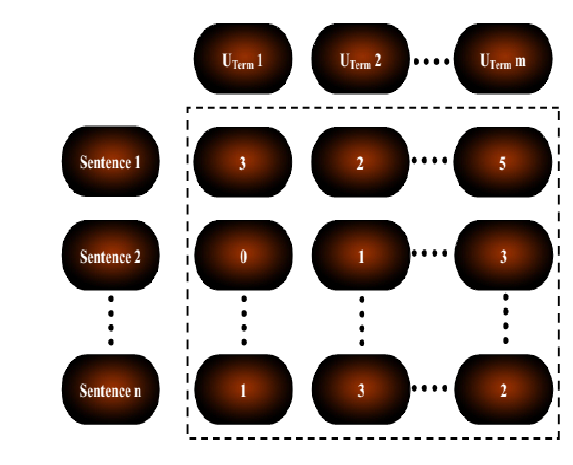
Figure 3. Term Frequency similarity Computation